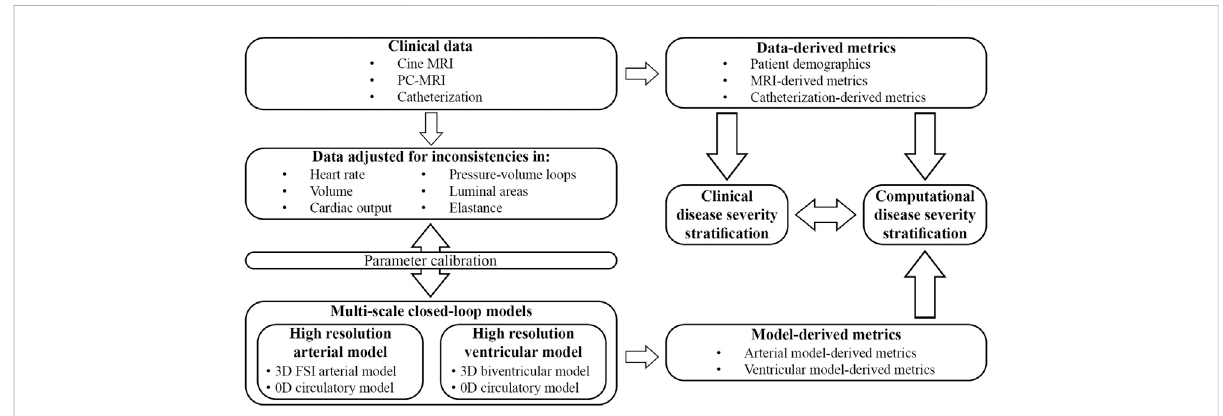
FIGURE 1 Clinical data was prospectivelyacquired in pediatric PAHpatients and adjusted to mitigate inconsistencies. Parameters of two different closed- loop multiscale models were calibrated and used to study computational metrics of disease severity. Clinically assessed disease severity, data- derived metrics, and model-derived metrics were correlated to stratify patients according to disease severity.